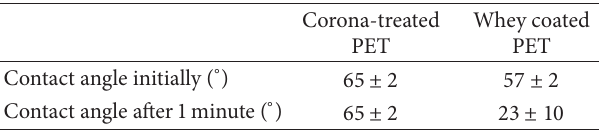
Table 1: Contact angle of water droplet onto used substrates before and after corona treatment and after whey-based coating